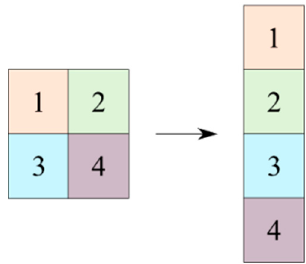
Figure 7. Graphic example of the flatten function.